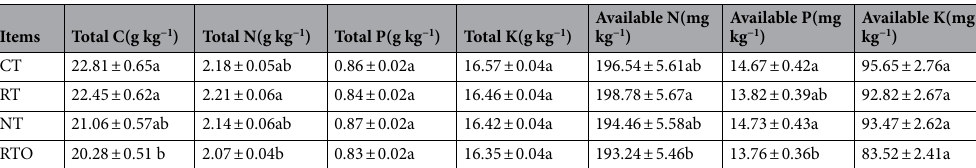
Table 1. Effects of different tillage management on soil chemical characteristic in a double-cropping rice field. Values were presented as means ± SE. Different lowercase letters in the same column were indicated significantly difference at p < 0.05 level. The same as below. CT conventional tillage with crop residue incorporation, RT rotary tillage with crop residue incorporation, NT no-tillage with crop residue retention, RTO rotary tillage with crop residue removed as a